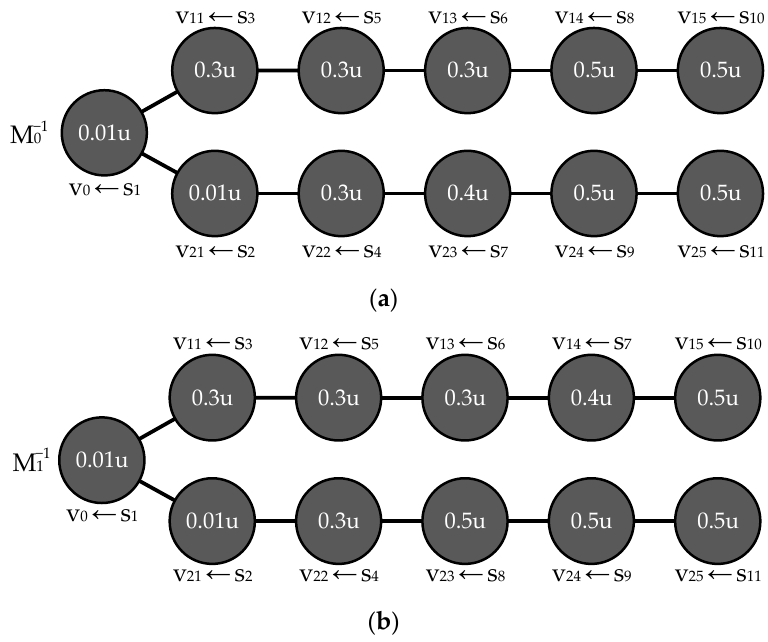
Figure 2. An example of a placement M 0 (cid:2879) 1 satisfying the conditions of both Statements 1 and 2 ( a ), and a placement M 1 (cid:2879) 1 satisfying the condition of Statement 1 but not Statement 2 and at the same time providing a lower value of integral risk ( b ).